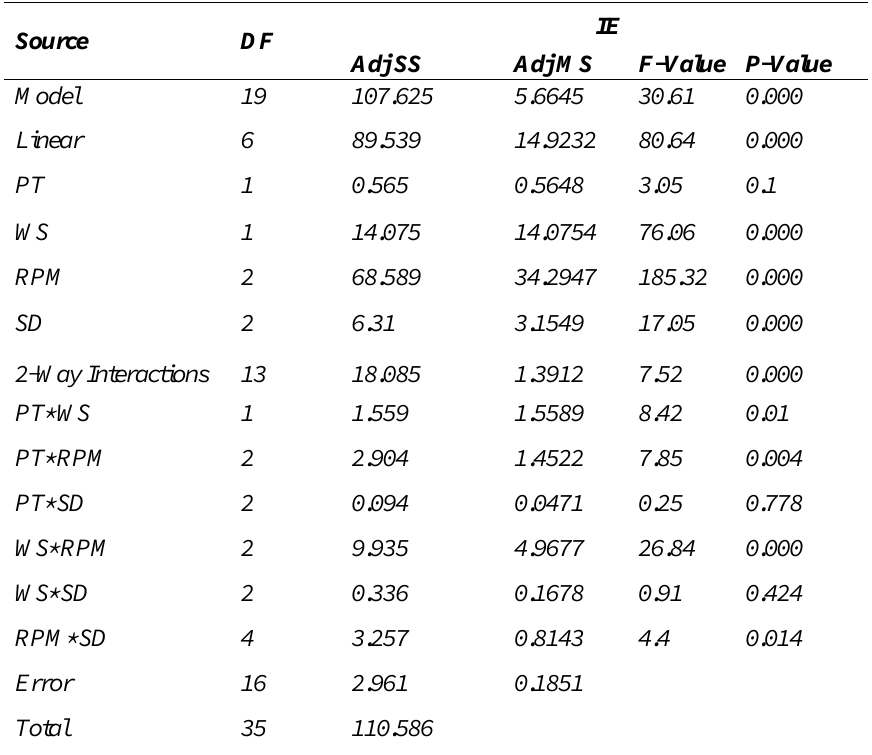
Table 5. Analysis of Variance